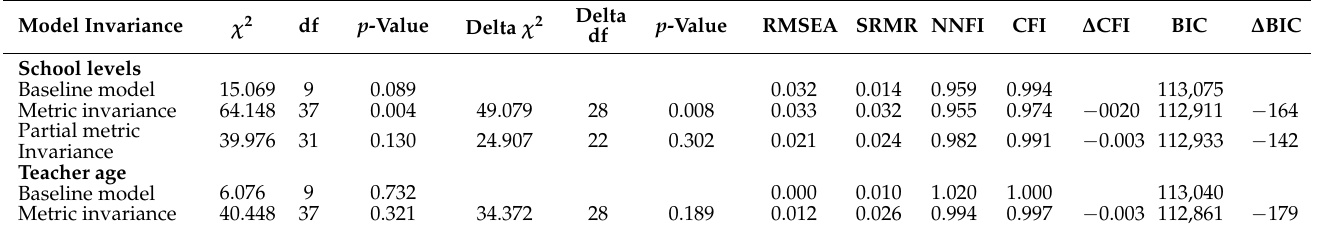
Table 4. Multi-group path analysis of Model